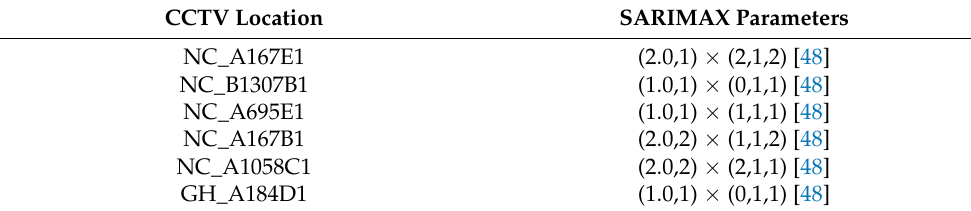
Table 4. SARIMAX tuned parameters per CCTV after grid